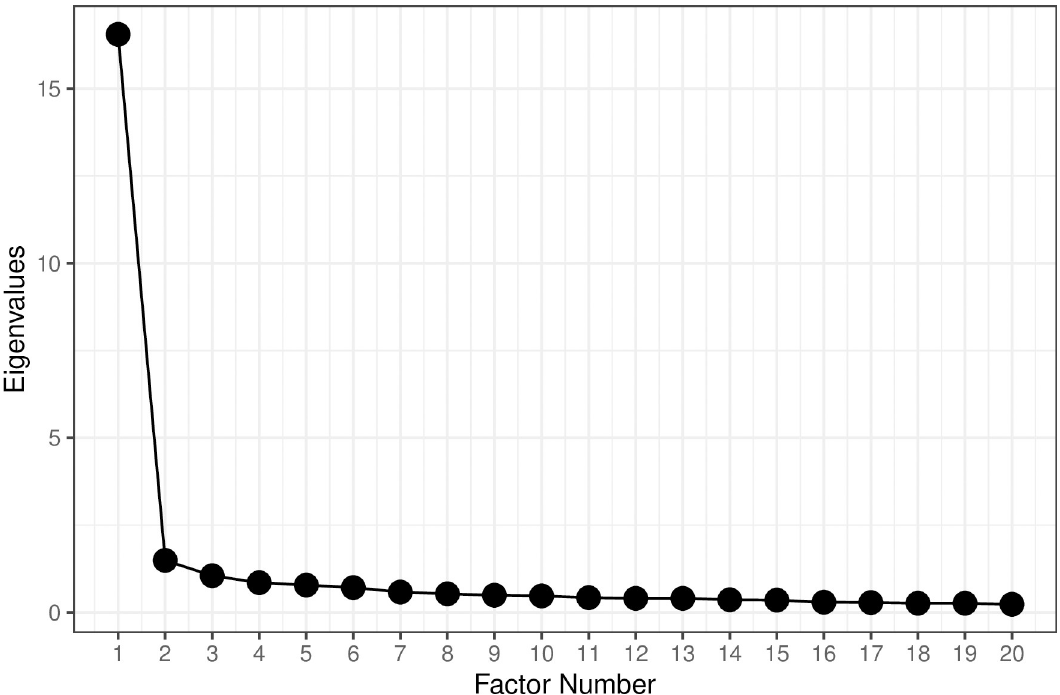
Fig 2. Scree plot of the eigenvalues (Study 1). Note: The number of factors shown here was limited to 20. The real maximum number of factors was 28.